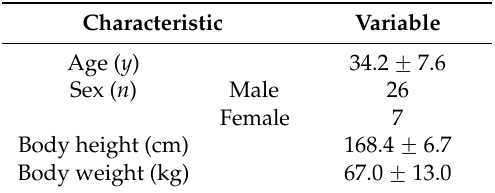
Table 1. Participant’s characteristics for this